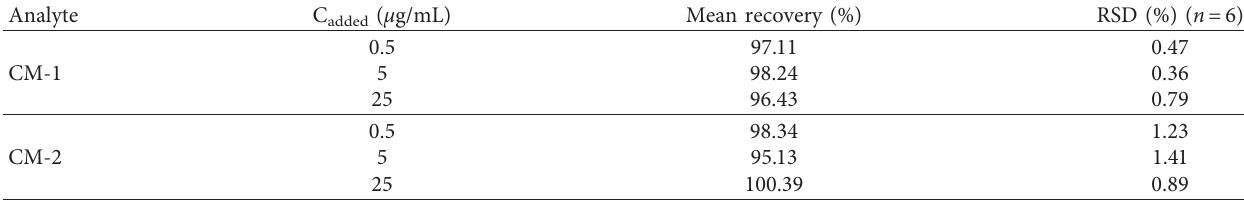
Table 3: Analytical recovery data of the two analysts during quantification ( n � 6).